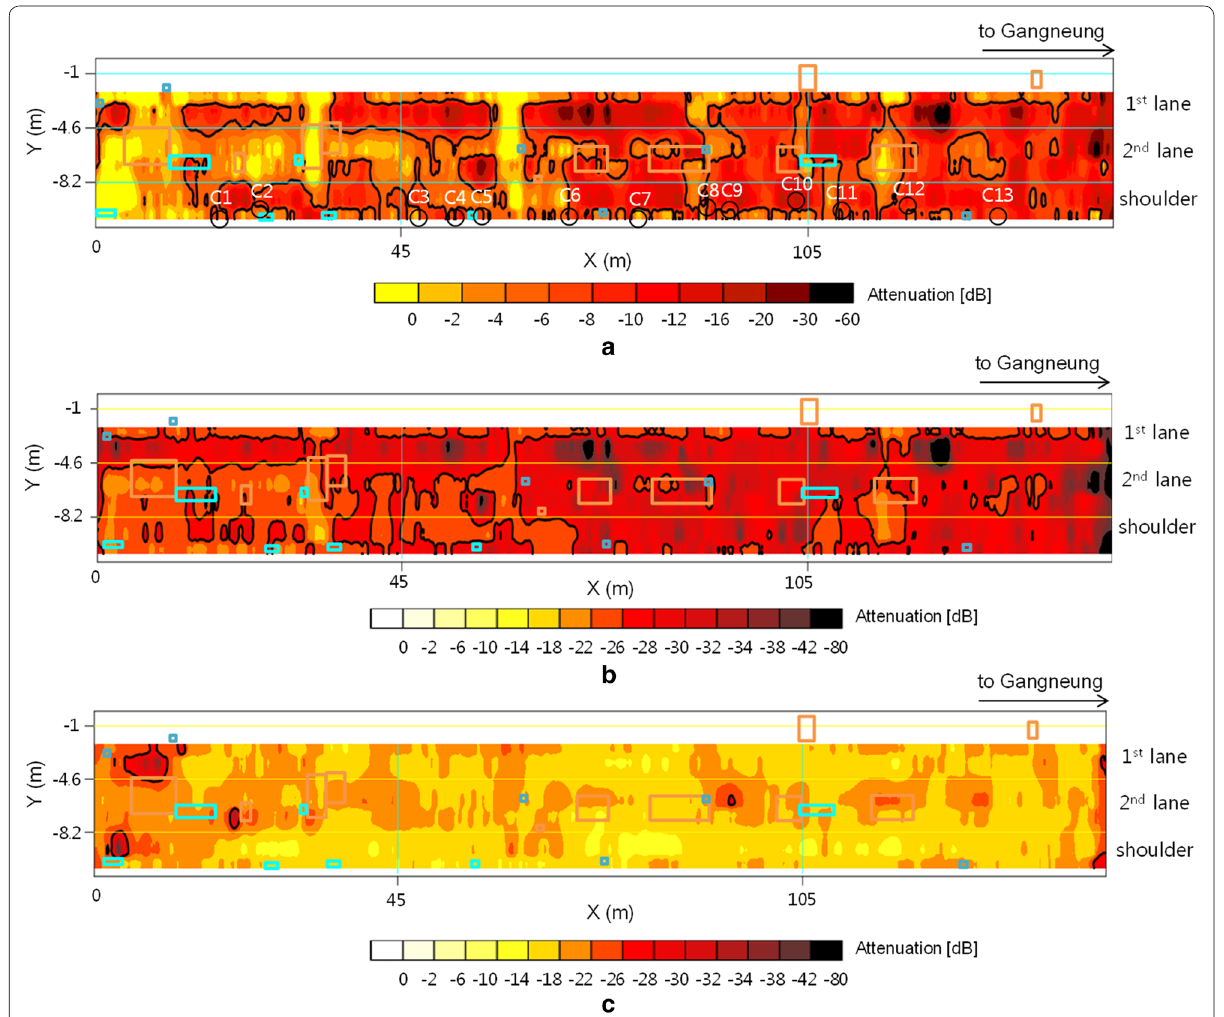
Fig. 12 Condition map based on the attenuation of EM waves measured by air‑coupled GPR system on the pilot bridge: a depth‑corrected attenuation of concrete cover (black lines indicating 6 dB), b total attenuation at top rebar (black lines indicating − of pavement layer (black line 26 dB). For a comparison, various types of damages on the surface in Fig. 5 are shown in the figure ( (cid:826) : core, ― : − surface‑breaking cracks, □ : efflorescence, □ : patching and □ :